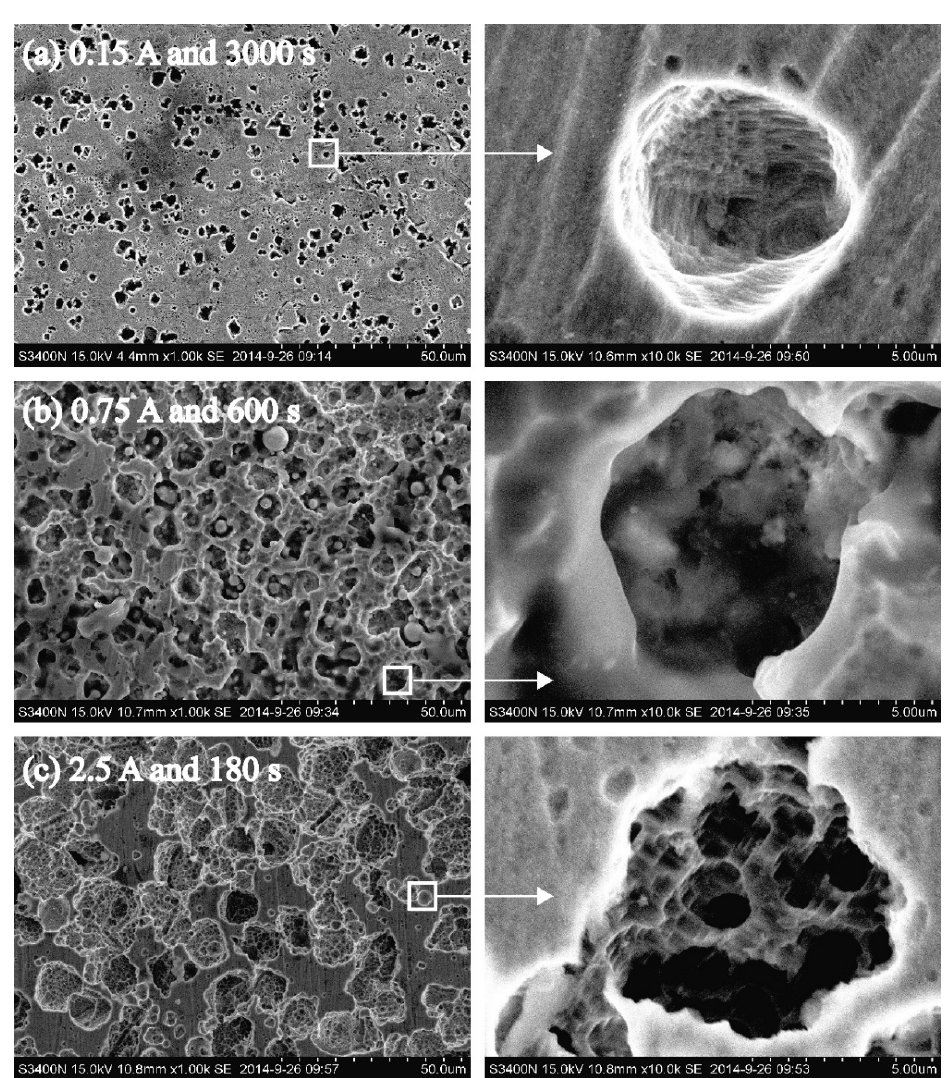
Figure 7. ( a – c ) Porous surface morphologies at different current